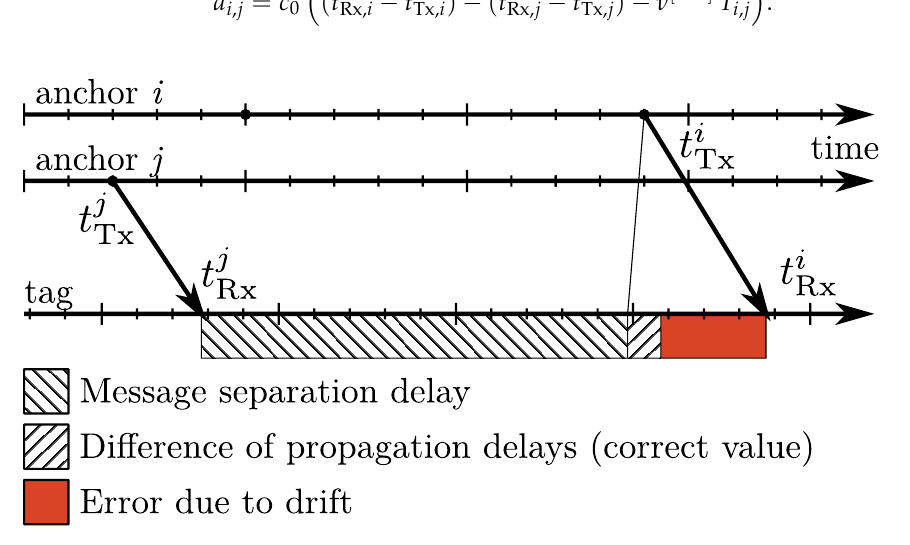
Figure 3. A2T TDoA measurement error due to